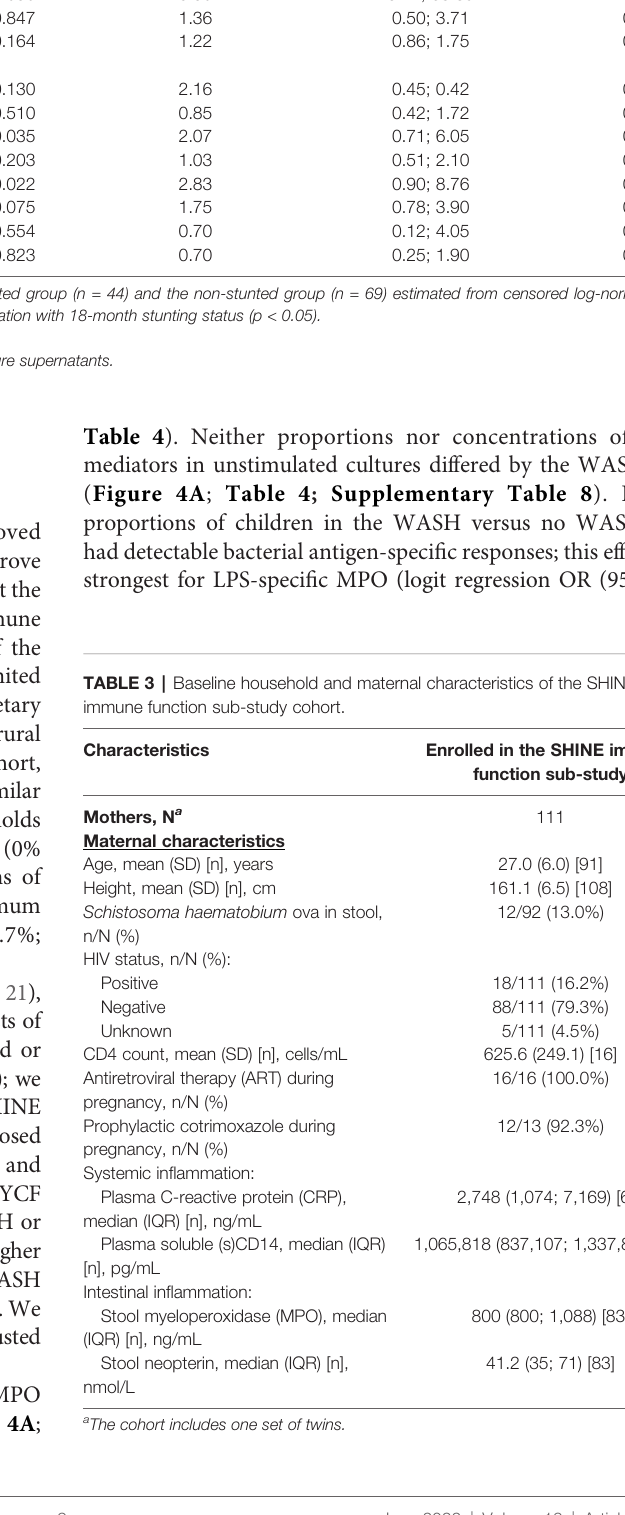
TABLE 2 | Censored log-normal (tobit) regression analysis of the relationship between child stunting status and immune-mediator production at 18 months of age. Outcome Unadjusted Adjusted for SHINE arm, hub, sex, and birthweight GMD a 95% CI p Adj. GMD a